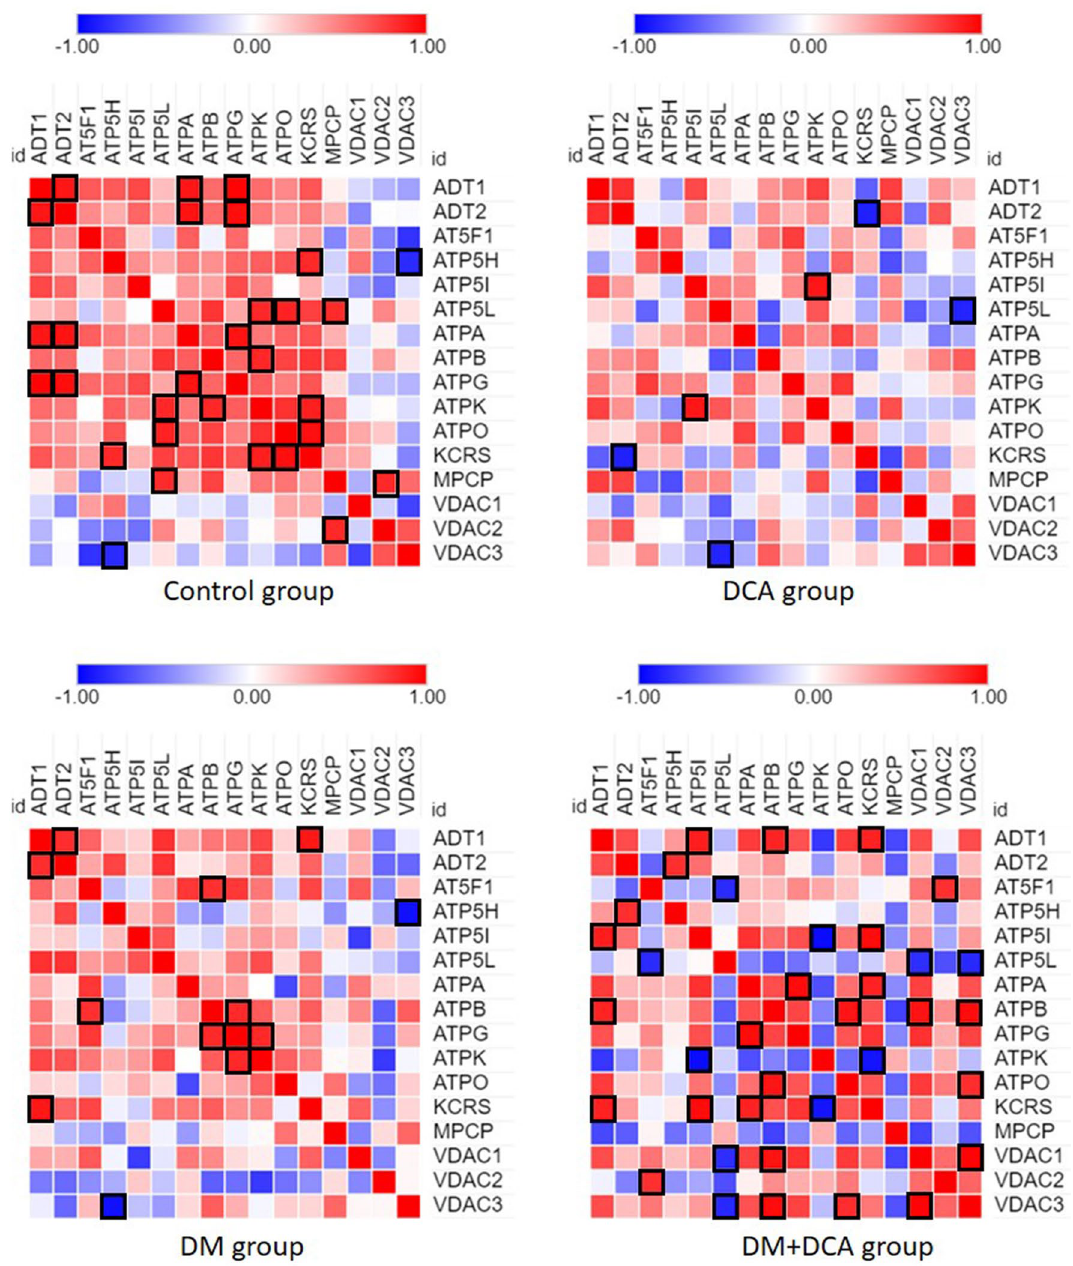
Figure 7. Pearson´s correlation heatmaps between the identified proteins involved in the structure and regulation of mPTPs stratified by experimental conditions. The color assigned to a point in the heat-map grid indicates the strength of a particular correlation between two proteins. The degree of correlation is indicated by red for positive correlations and blue for negative correlations, as depicted in the color key. Statistically significant correlations are marked using cell borders. The upper triangle half of the correlation matrix is axially symmetric along the diagonal to the lower triangle